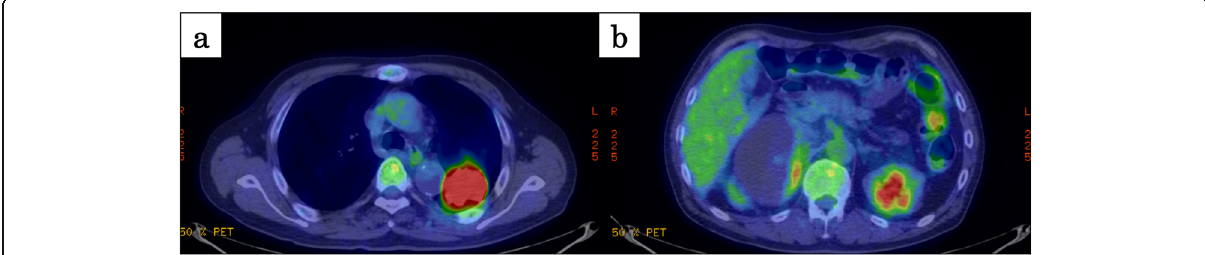
Fig. 2 Imaging of FDG-PET. a There was high accumulation of FDG at the left lung tumor (SUVmax, 17.0). b There was slightly accumulation of FDG at the edge of abdominal tumor (SUVmax,